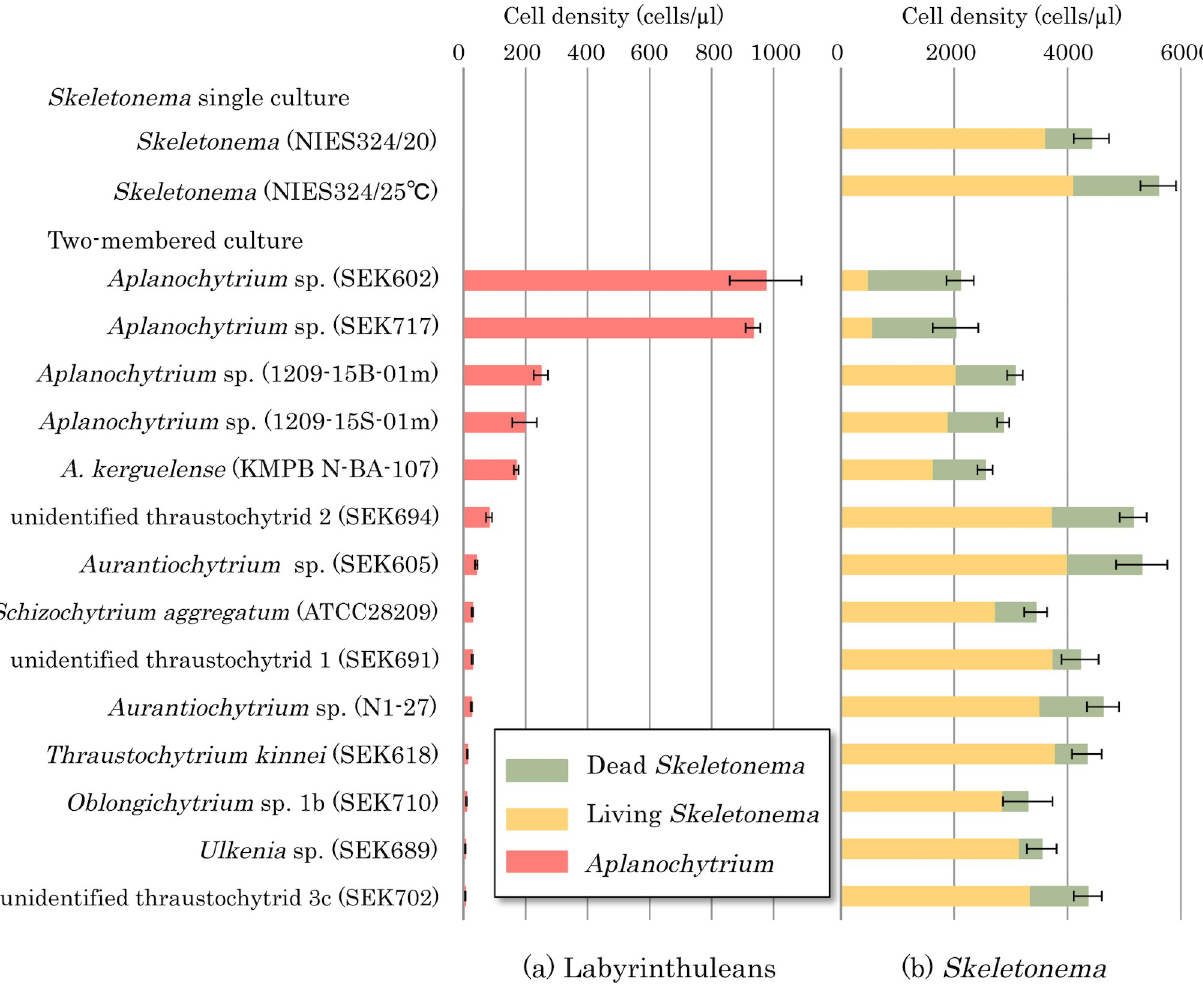
Fig 6. Numbers of labyrinthulean cells and Skeletonema living/dead cells in two-membered culture. (a) Cell numbers of labyrinthulean strains. (b) Numbers of living (yellow) and dead (green) Skeletonema cells.